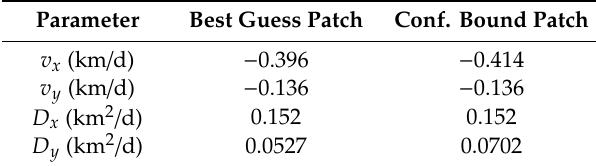
Table 3. SOSim’s inferred velocity and di ff usion parameters for M / T Athos I